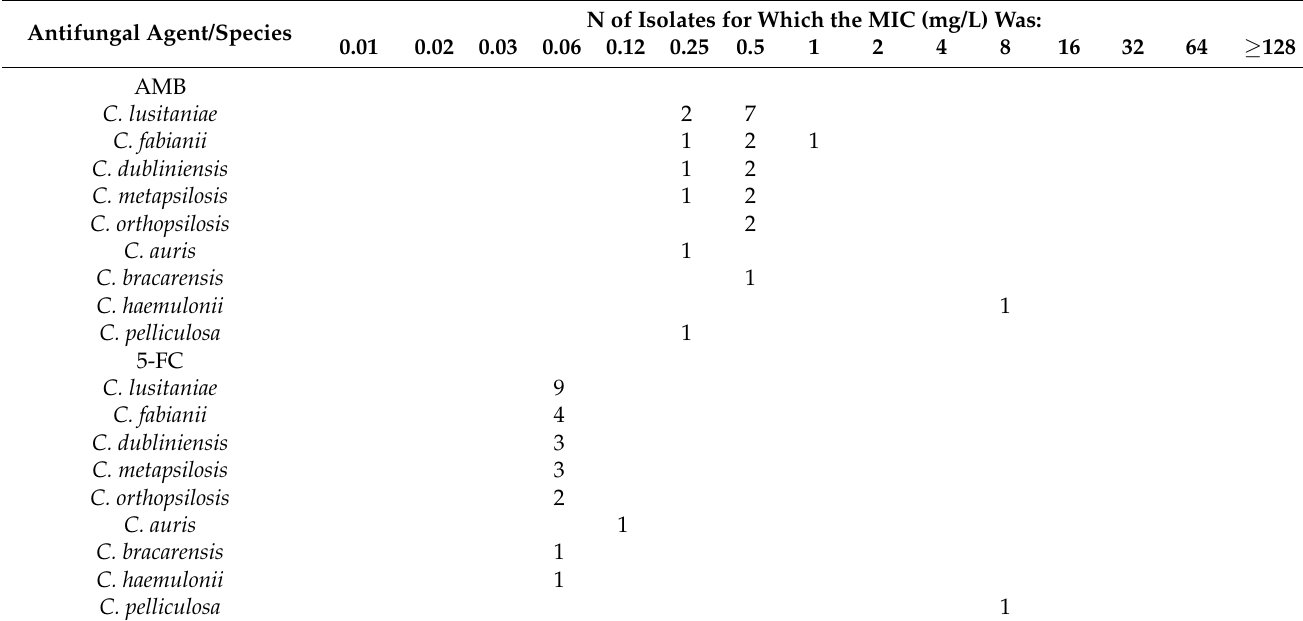
Table 5 summarizes the antifungal resistance mechanisms of 24 Candida bloodstream isolates. All 23 fluconazole non-susceptible Candida isolates were from HO infections. Of the seven fluconazole-resistant isolates of C. glabrata from six hospitals, six